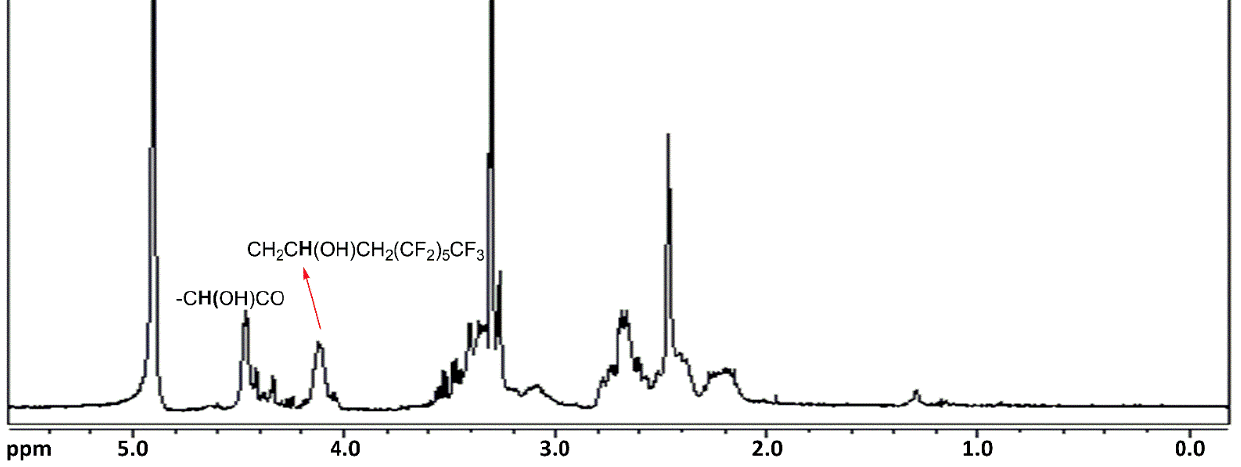
Figure 7. 1 H NMR spectrum in CD 3 OD of oligoamide ESTF.